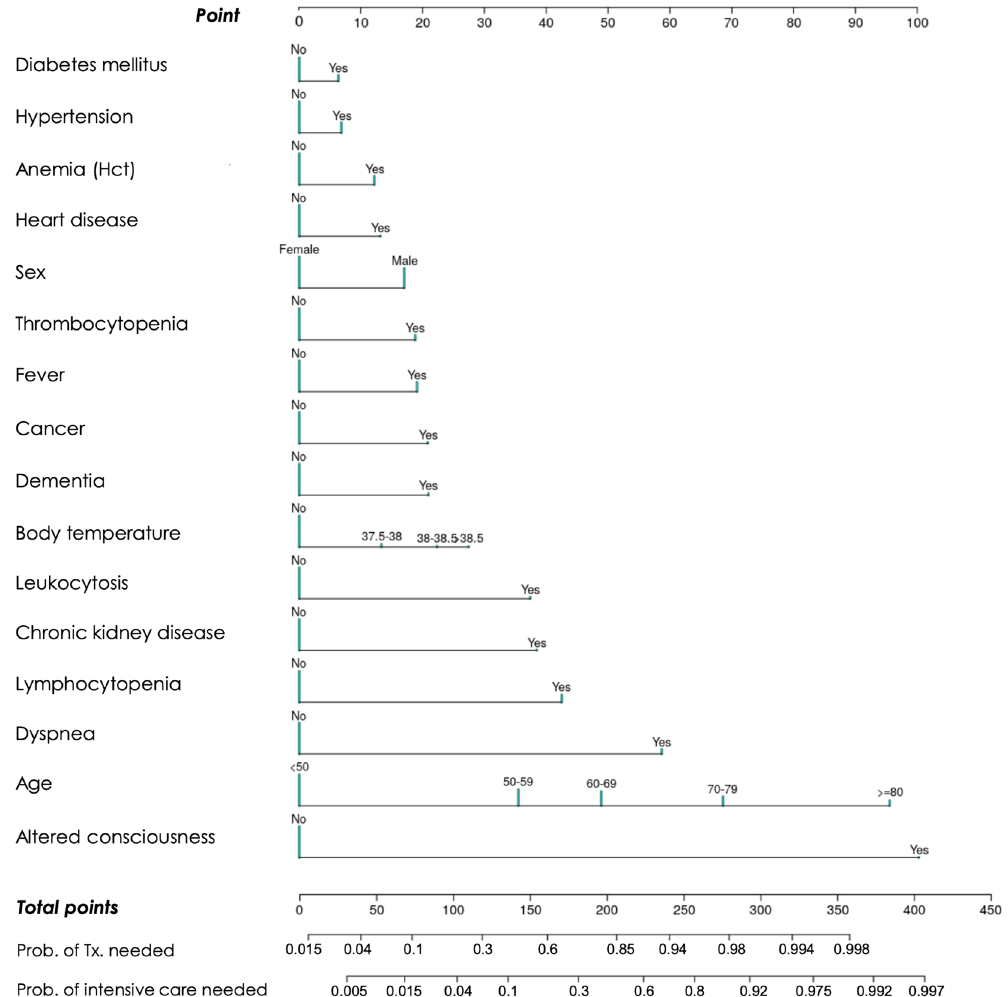
Figure 3. Nomogram of ordinal logistic regression model using all the predictors (Model 4). The nomogram is used by first giving each variable a score on the ‘Point’ scale. The points for all variables are then added to obtain the total points and a vertical line is drawn from the ‘Total points’ row to estimate the probability of requiring treatment and that of requiring critical care or death. The nomograms of the other models can be found in Supplementary Fig. S1.